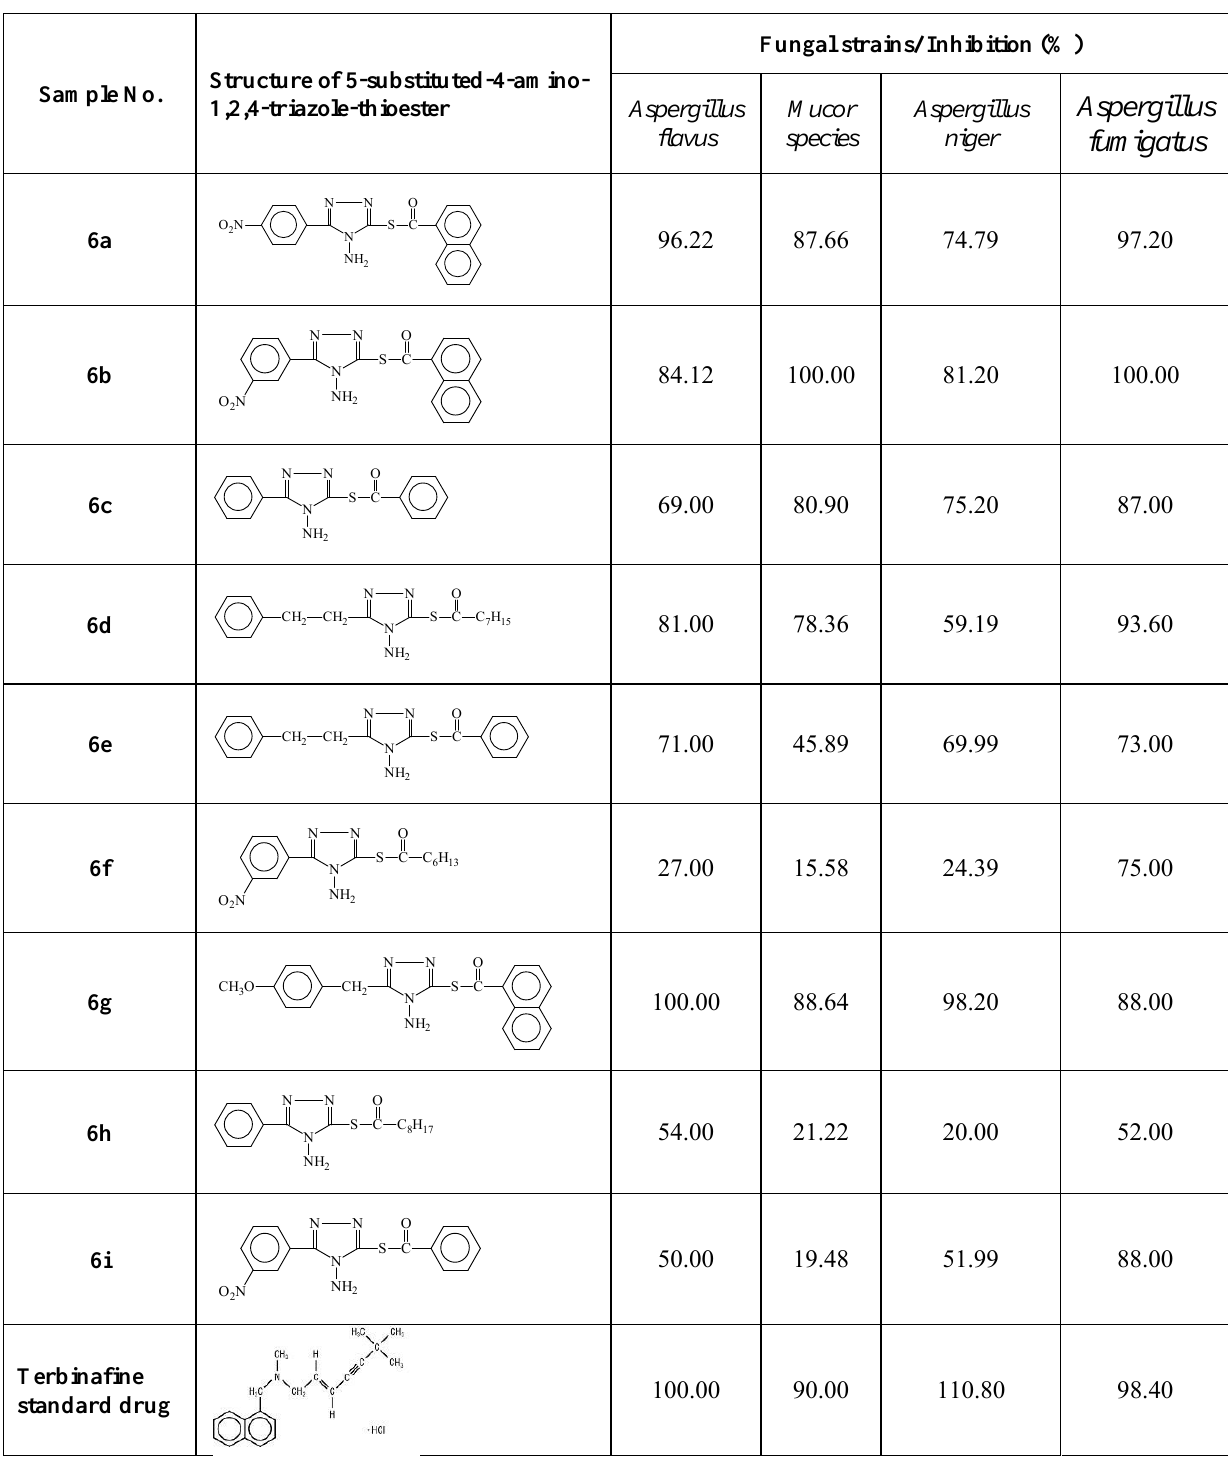
Table 3. Antifungal activity of 5-substituted-4-amino-1,2,4-triazole-3-thioesters.